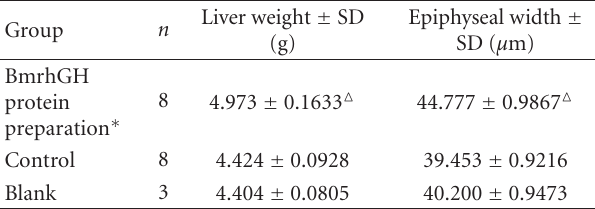
Table 1: The liver weight and epiphyseal width of hypox rats gavaged with BmrhGH (mean ±